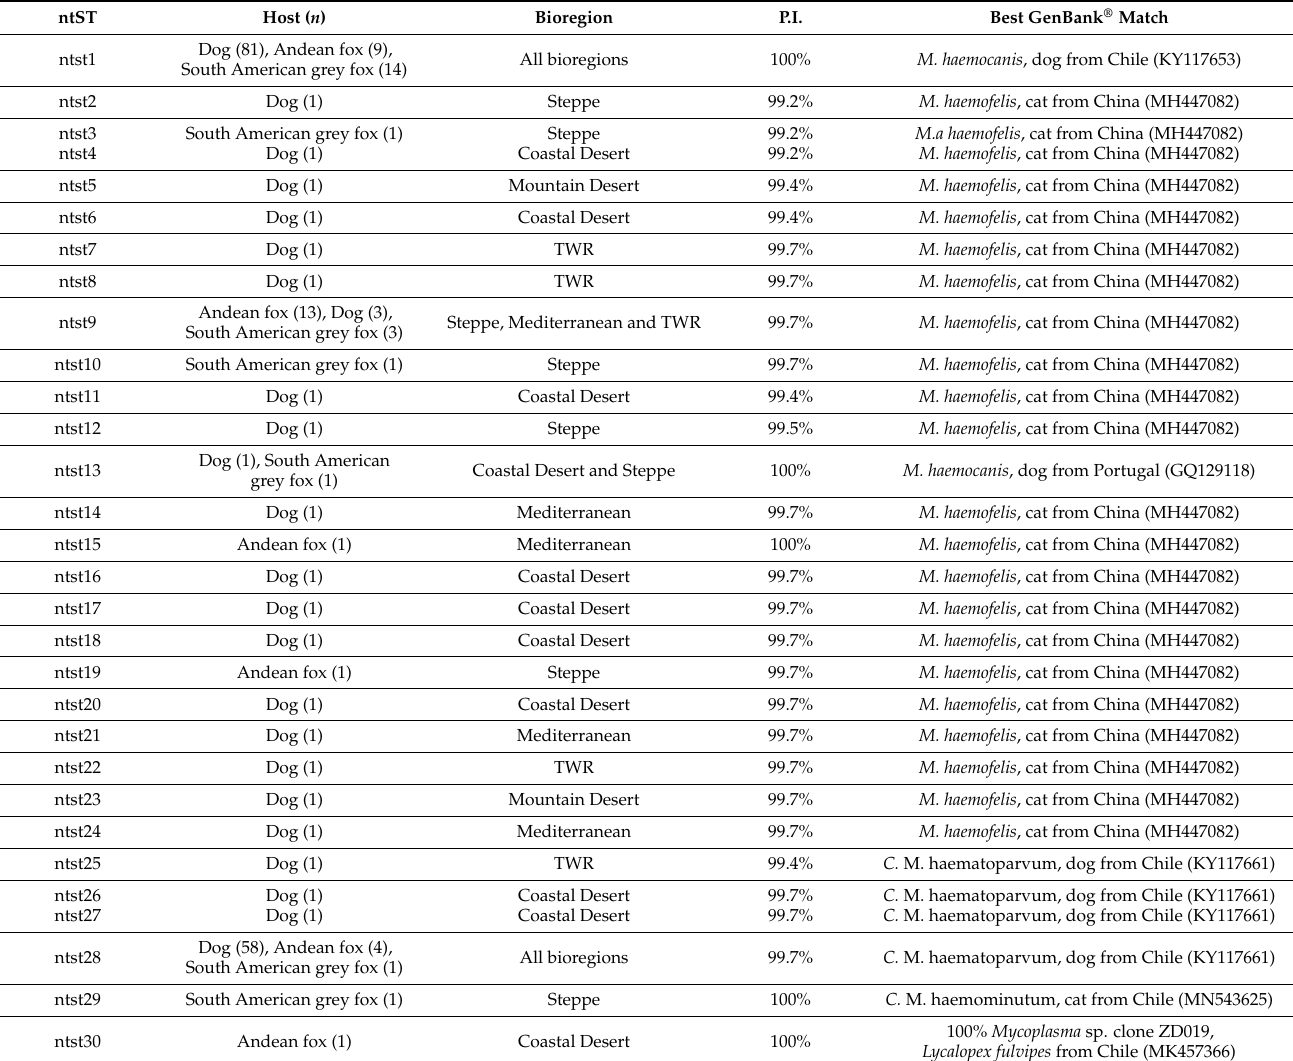
Table 3. Mycoplasma sp. 16S rRNA sequences types detected in rural dogs and foxes in